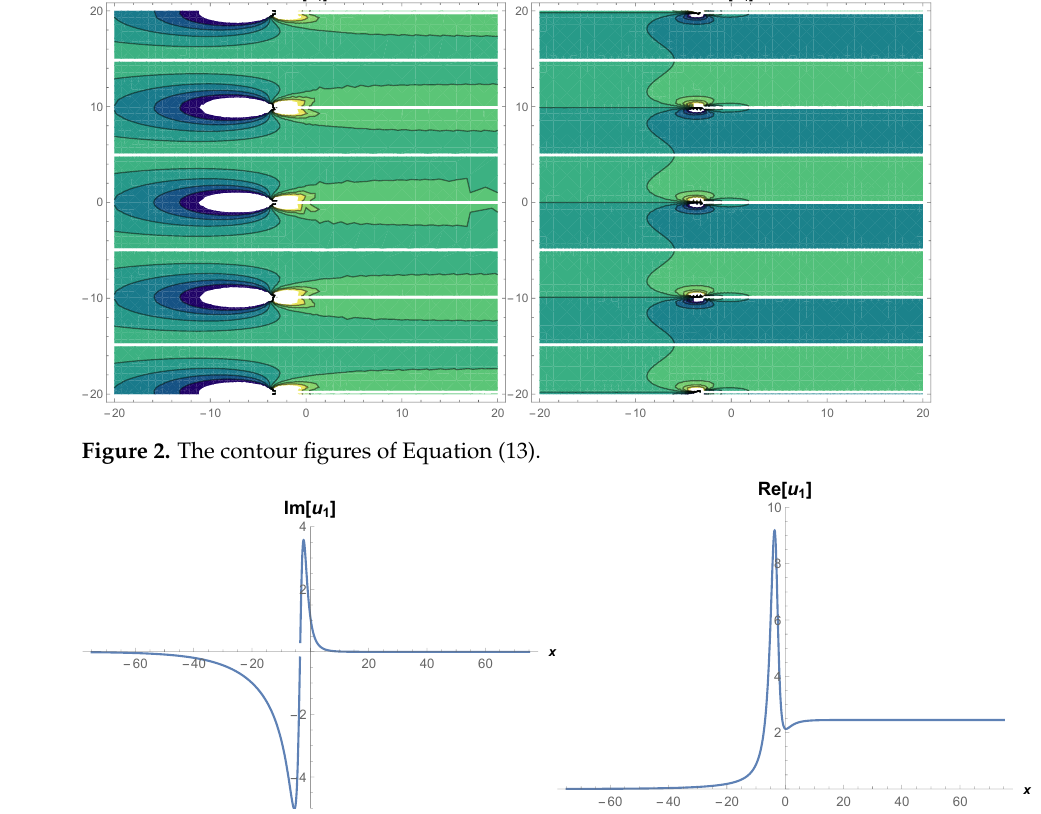
Figure 3. The 2D figures of Equation (13).